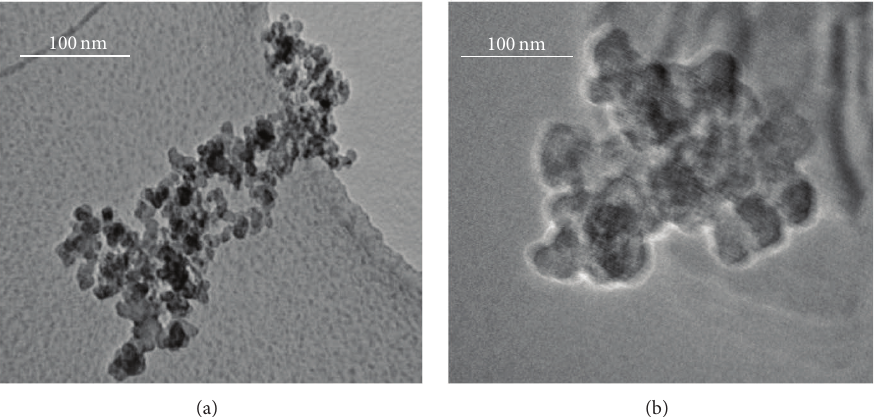
Figure 1: Transmission electron micrograph of carbon particles: (a) nanocarbon and (b) microcarbon. Scale bar is 100nm.